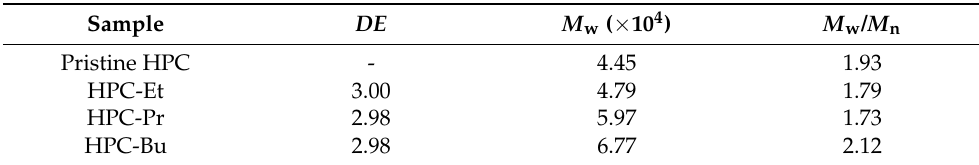
Table 1. Characterization of pristine HPC and its ester derivatives possessing alkanoyl side chains with the different